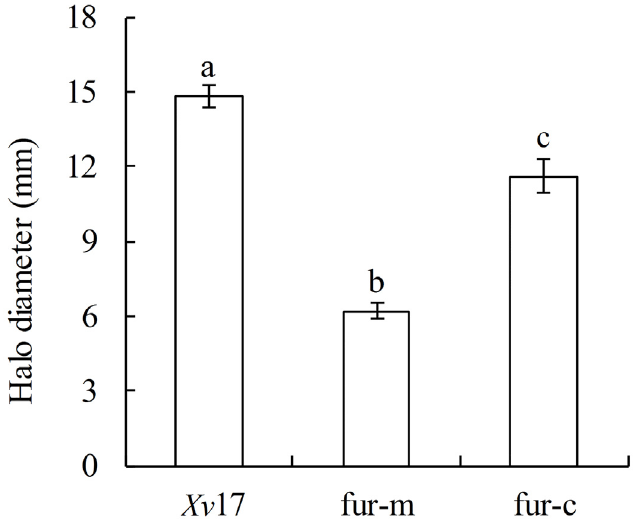
Fig 4. Comparison of swimming motility in Xv strains. Bar heights are the mean diameter of the swimming halos from three replicates ± standard deviation (SD). Different letters above the bars indicate significantly different diameters ( P < 0.05) based on Duncan ’ s multiple range test.